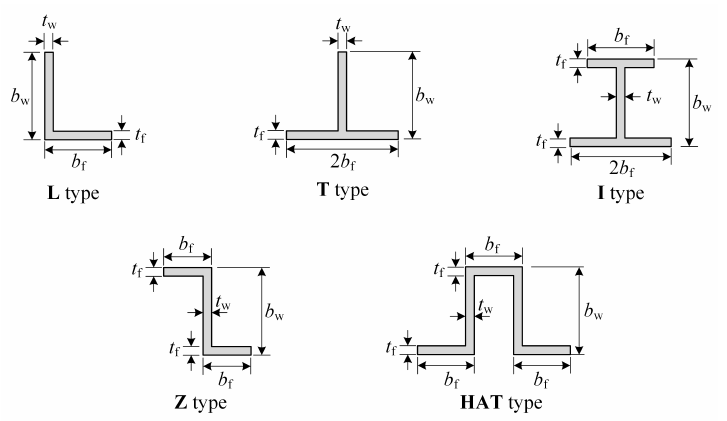
Figure 2. Section types of stiffeners.